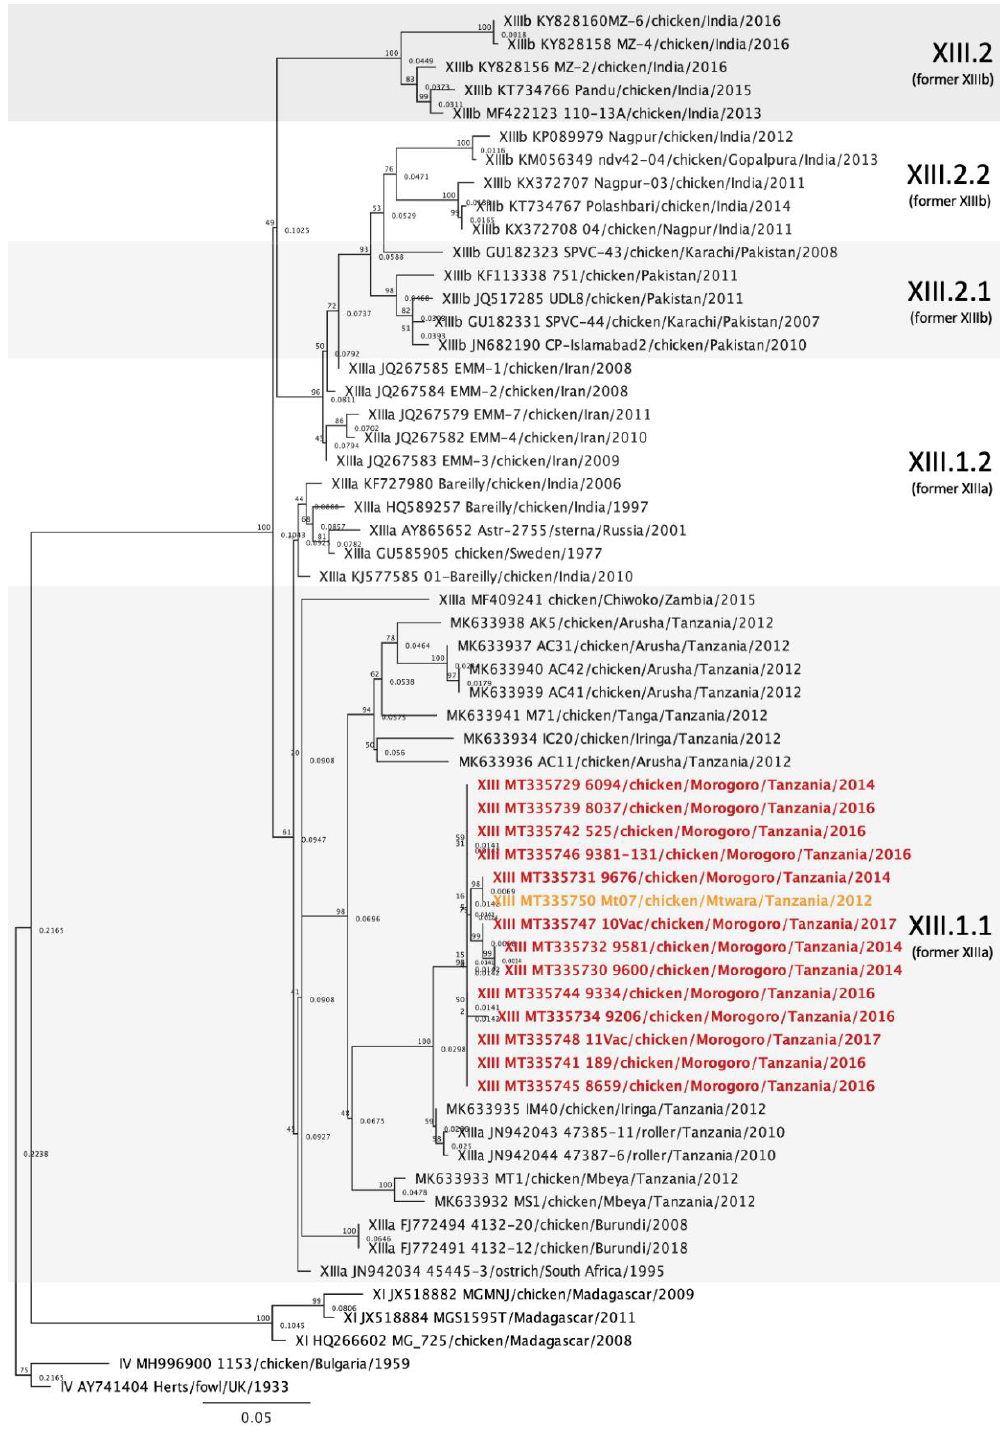
Figure 5. Phylogenetic analysis of Newcastle disease virus genotype XIII isolates using a 615-bp fragment of the fusion gene with the maximum likelihood method with 1000 bootstrap replicates. Of the 60 sequences used, 13 were collected from diseased chickens from Morogoro and one from Mtwara, Tanzania (bolded and colored), 41 represent other genotype XIII isolates [5], and 5 are outliers (2 from genotype IV and 3 from genotype XI). The roman numerals on the right represent the genotypes the isolates belong to. The previous terminology [4] is listed below the current nomenclature in parenthesis for reference. The colors represent the geographic location of the isolates (orange = Mtwara, red = Morogoro).